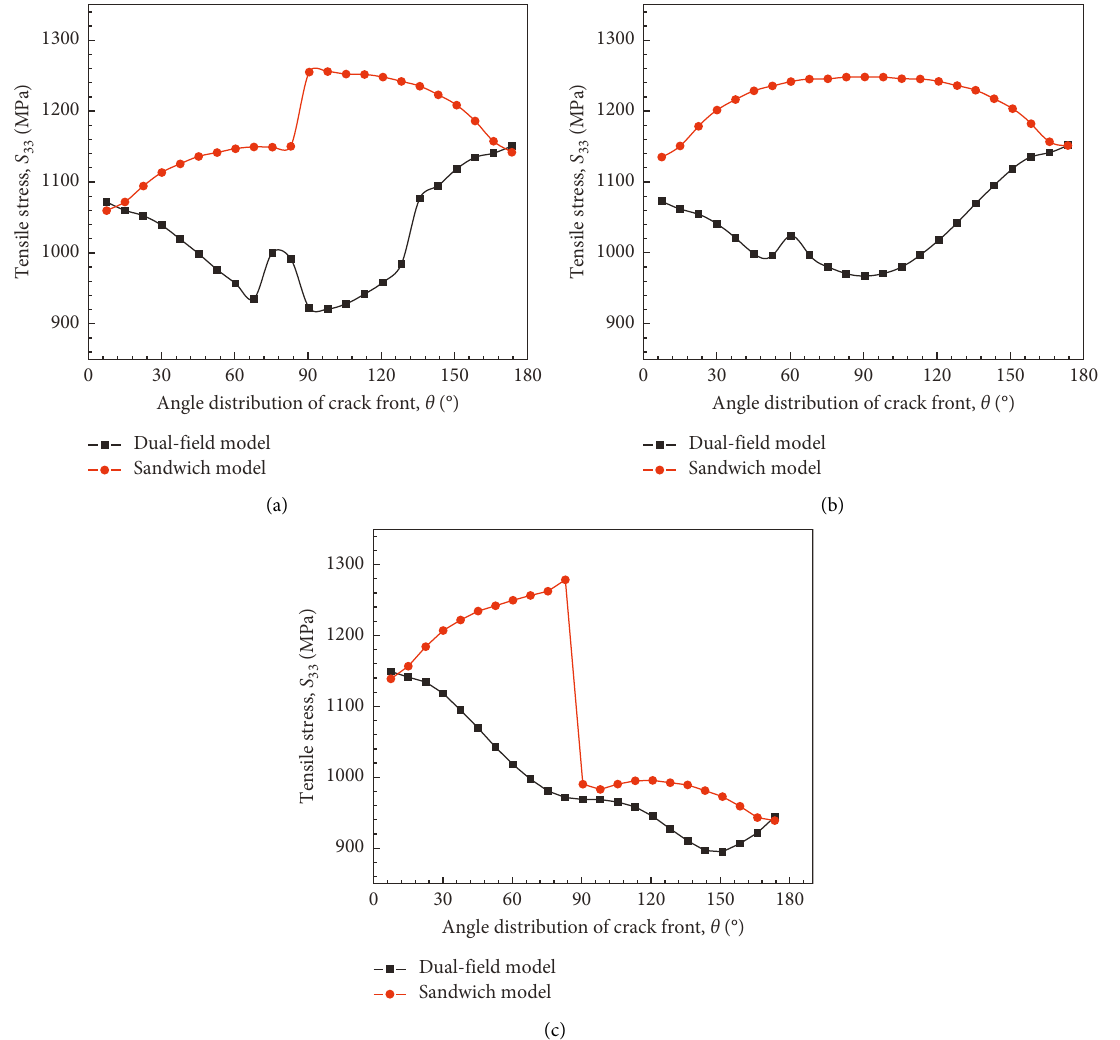
Figure 9: Distribution of tensile stress along crack front with crack angle. (a) Crack-10. (b) Crack-1. (c)